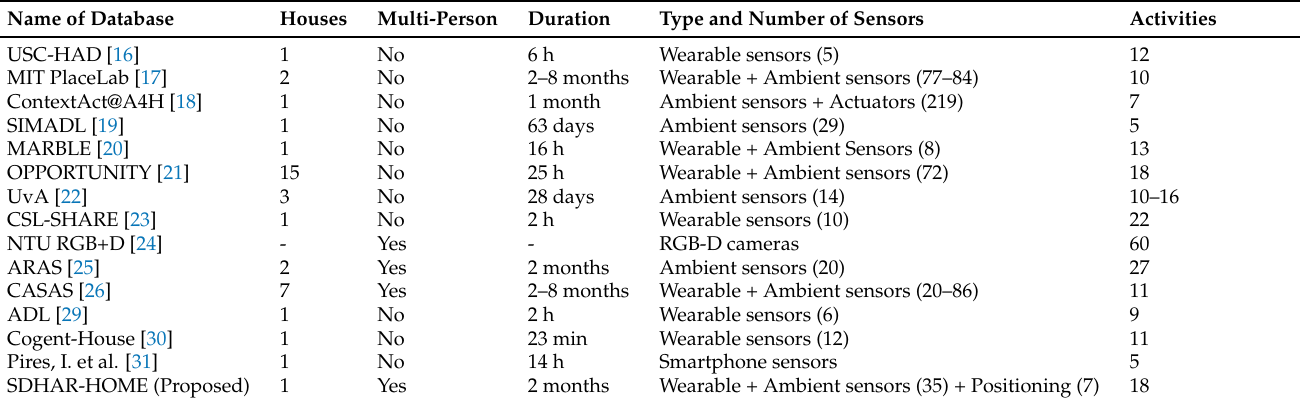
Table 1. Overview of major databases on activities of daily